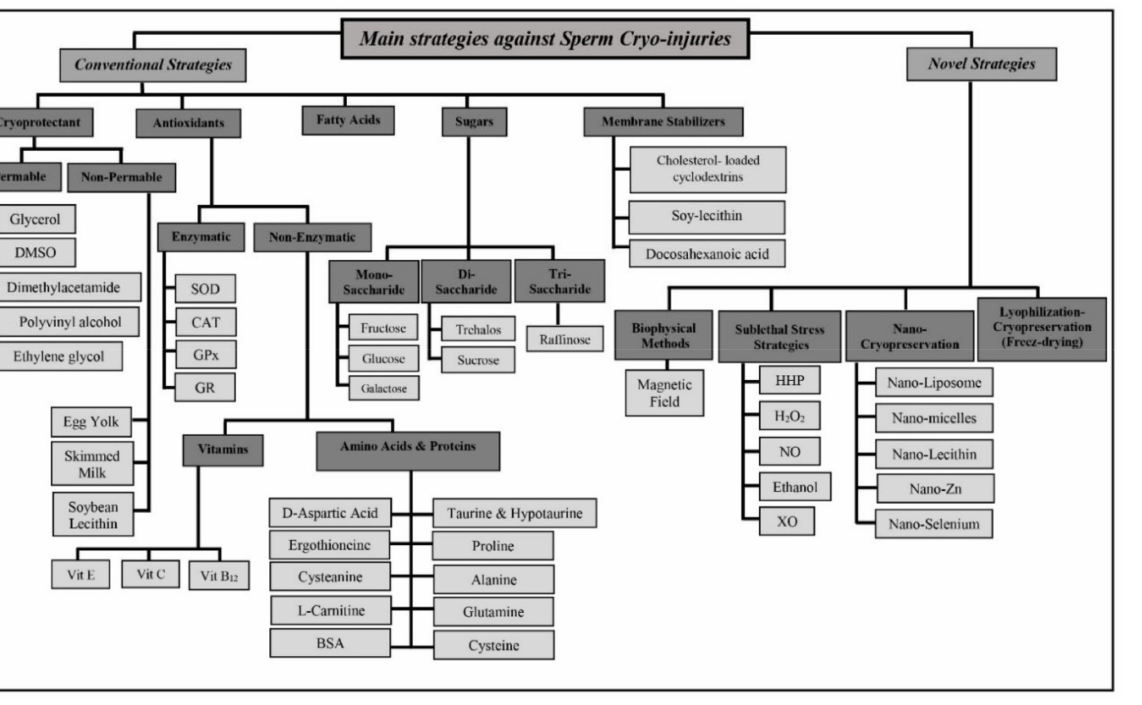
Figure 2. Main strategies to prevent animal sperm cryo-injuries (note all acronyms are in the abbrevi- ation